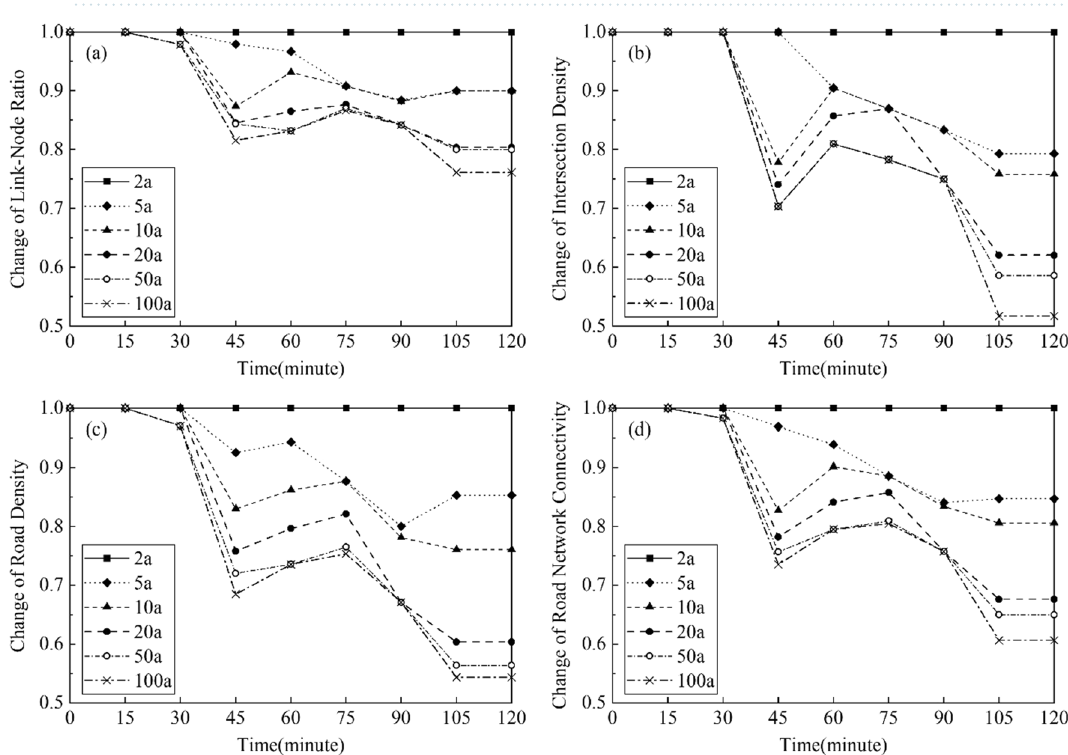
Figure 14. Changes of road connectivity in the hotspot of the case area: ( a ) Link-Node Ratio; ( b ) Intersection Density; ( c ) Road Density; ( d ) Road Network Connectivity. This graph was generated with OriginPro 2021 (Learning Edition)(https:// www. origi nlab.